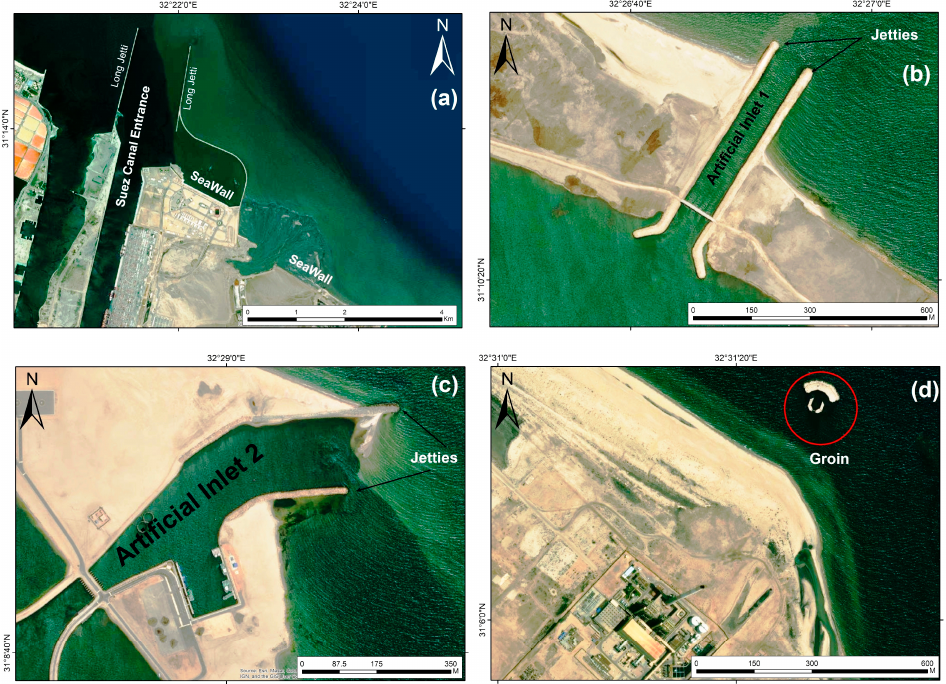
Figure 10. Coastal protection devices along the El Tienah Plain. ( a ) Suez Canal Entrance Jetties; ( b ) Jetties of Artificial Inlet-1; ( c ) Jetties of Artificial Inlet-2; and ( d ) Onshore Groin. Sections C and E had an annual accretion rate of 5.6 m/year and 4.1 m/year, respec- tively. Section F, which is located downward of the TPC, is stable with an average annual accretion of 30 cm/year. According to the CEDM, sections C, E, and F are “stable” regions along the